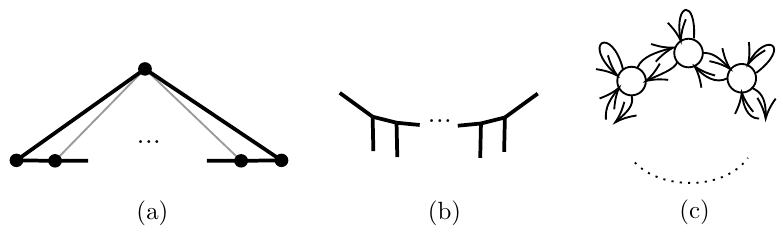
Figure 3 . (a) The toric diagram for C × C 2 / Z n composed of n simplices horizontally arranged in the figure. (b) Its dual web diagram with n vertical lines in the figure. (c) The corresponding quiver with n